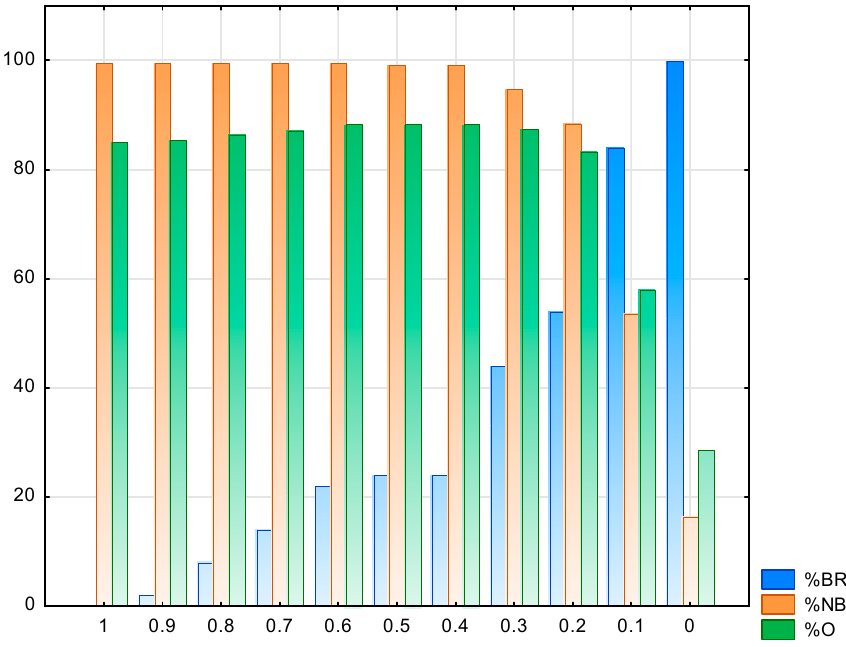
Figure 4. Percentage of correct predictions using the Logit model.